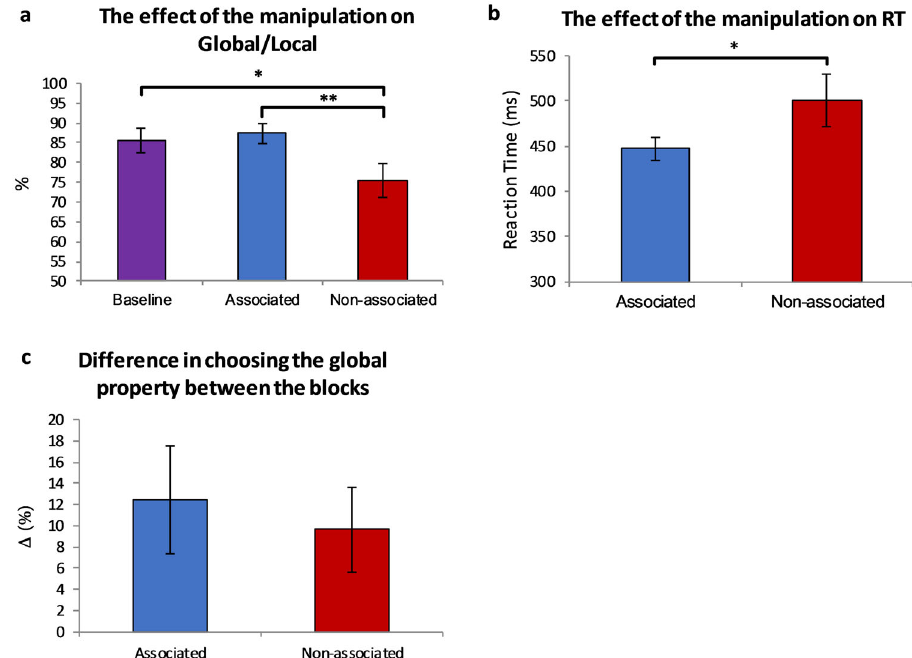
Fig. 4 Global vs. local results. a The results of the three blocks (baseline, associated, and non-associated). The number of times that participants chose the global property over the local property was higher in the associated block. No signi fi cant difference was found between the baseline and the associated block. The results in %. b The reaction time was found shorter in the associated block. c No signi fi cant difference was found in the number of times that participants chose the global property between the blocks indicates that the starting block did not affect the results. Purple, Baseline; Blue, Associated block; Red, Non-associated block. Error bars indicate the standard error of the mean, and asterisks indicate signi fi cant differences between conditions (** p < 0.001, * p <